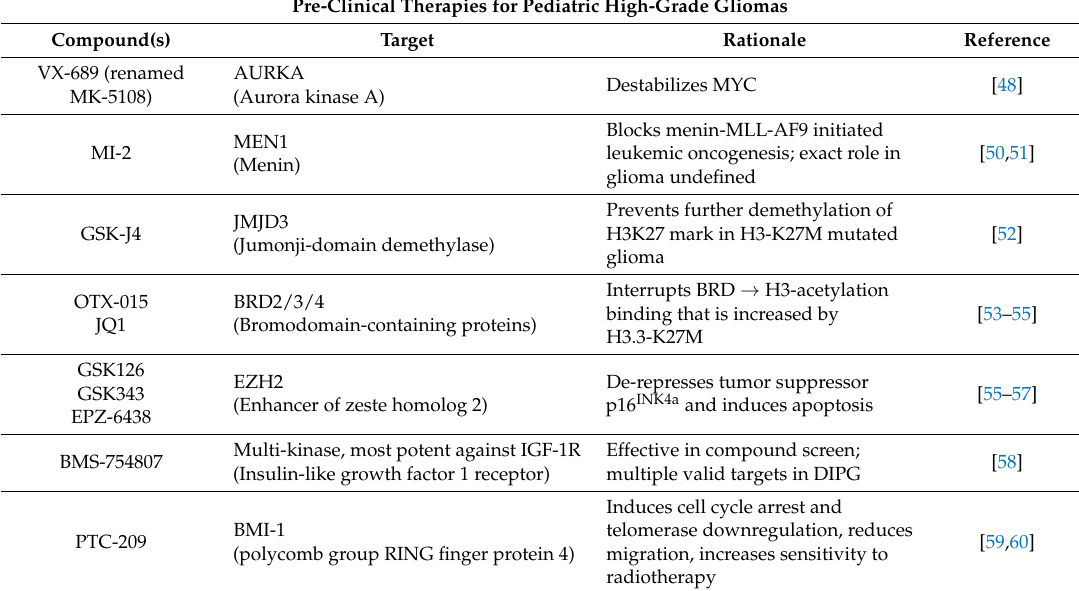
Table 2. Experimental pre-clinical therapeutics for pediatric high-grade gliomas including compound name, target of therapy, rationale for use in this disease, and